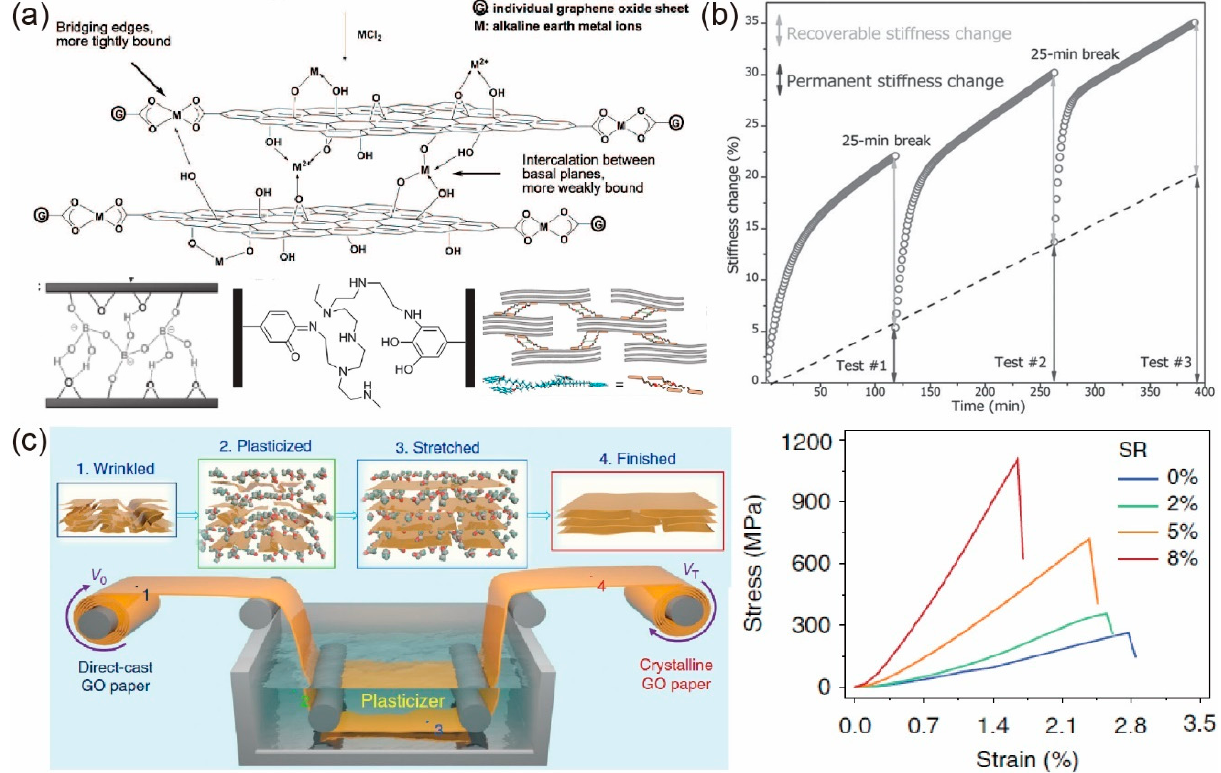
Figure 11. Stiffening and strengthening strategies for graphene papers (GPs). ( a ) Schematic plots of crosslinks introduced to adjacent sheets including (top) divalent bonds, (left to right in the bottom row) borate, polymers, and π – π crosslinking. Reprinted with permission from [142,147–149]. ( b ) Self-stiffening approach by cyclic stretching with small strain amplitude. Reprinted with permission from [151]. ( c ) Plasticizer-assistant stretching method to straighten the wrinkles of direct-cast GO papers, and the resultant stress–strain curves. Reprinted with permission from [143].